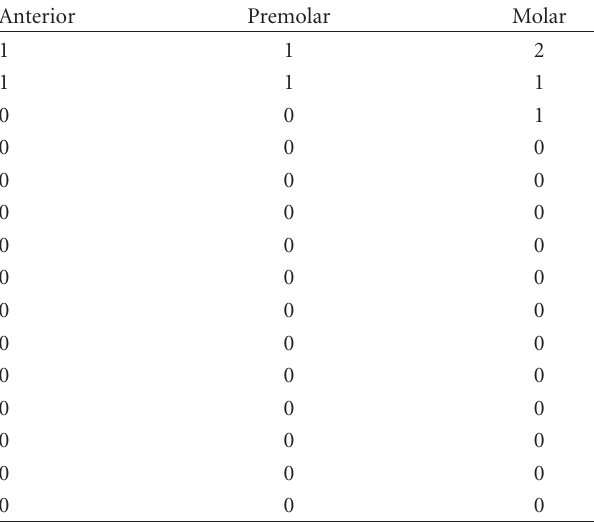
2 mL of local anesthetic solution containing 80 mg Articain HCl and 0.012 mg epinephrine was used (Ultracain D-S, Sanofi-Aventis, Istanbul, Turkey). 1.7 mL of the solution was injected according to conventional methods [9] (Figure 1). The remaining 0.3 mL of the solution was left to use for PA if the patient would have a pain during the extraction.